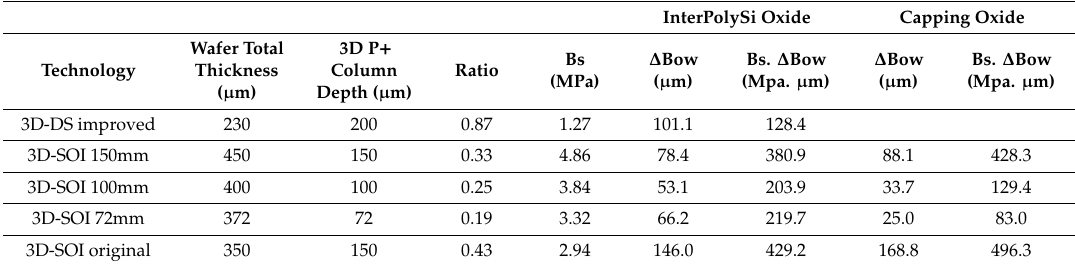
Table 3. Estimation of parametrized bow in critical steps of 3D technologies.